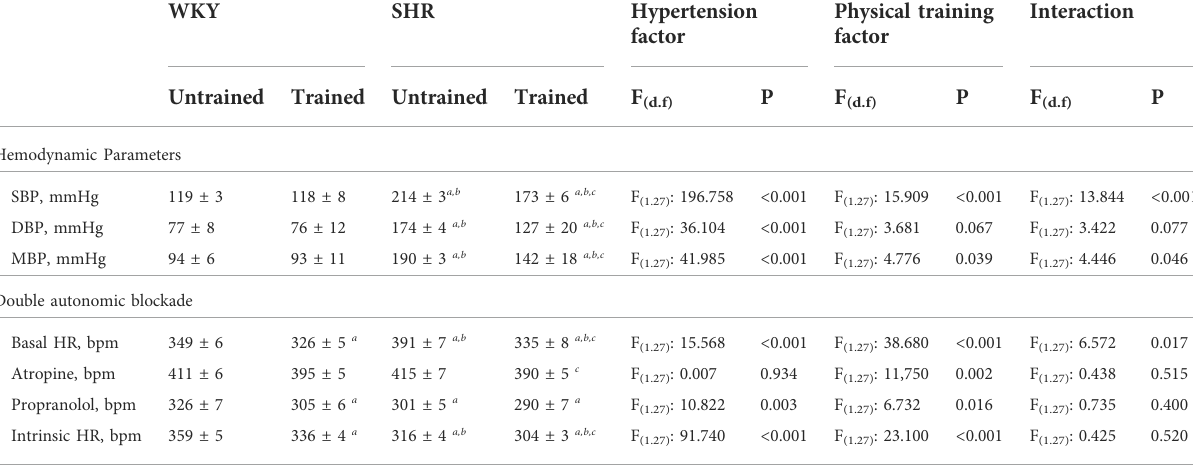
TABLE 1 Hemodynamic parameters and values of heart rate (HR) obtained before and after the double pharmacological blockade of cardiac autonomic receptors with atropine and propranolol, in Wistar Kyoto (WKY, N = 14) and Spontaneously Hypertensive Rats (SHR, N = 14) groups, both untrained ( N = 07) and trained ( N =